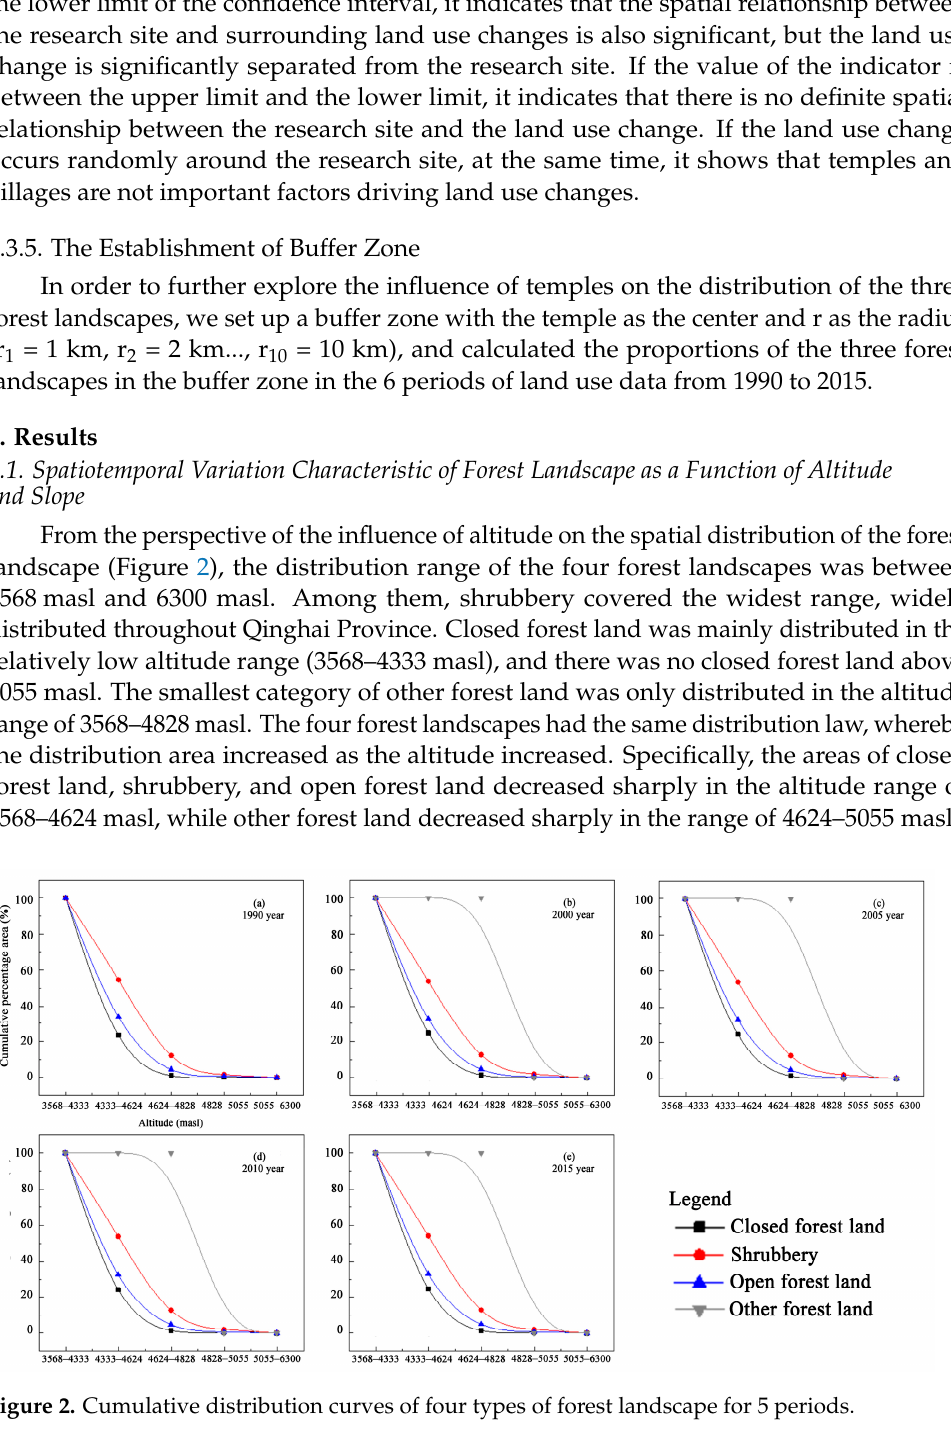
Figure 2. Cumulative distribution curves of four types of forest landscape for 5 periods.